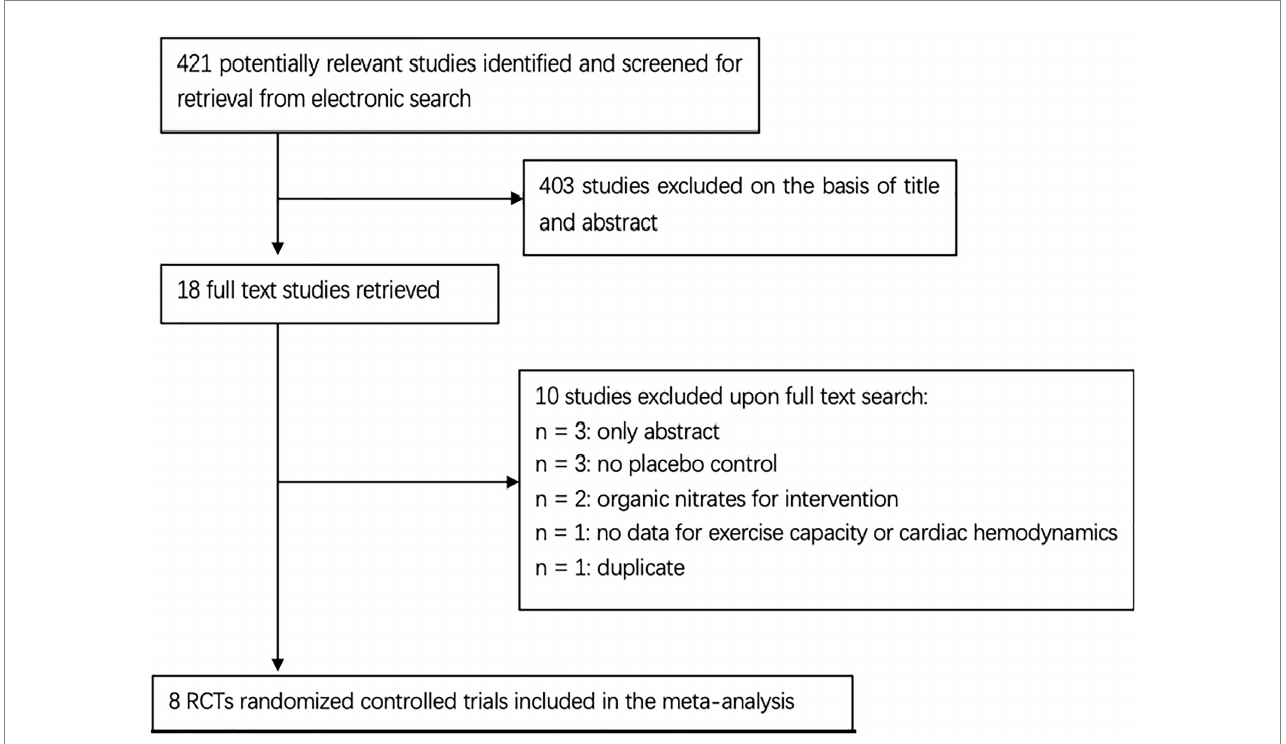
FIGURE 1 Flow diagram of the study selection